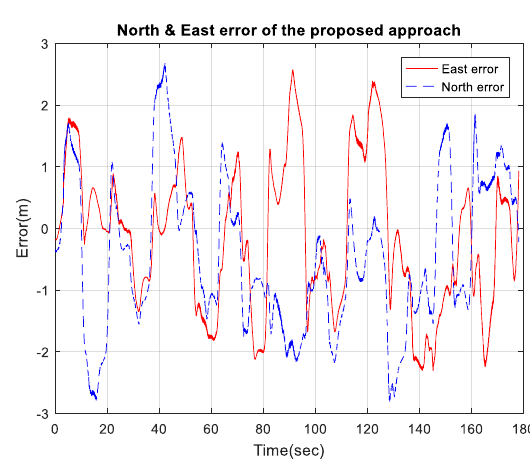
Figure 16. RMSE Errors trend in North and East directions for the proposed approach (camera and UWB) integrated with INS system with lower infrastructure utilized for a complete 3- minute GNSS signal outage (configuration f